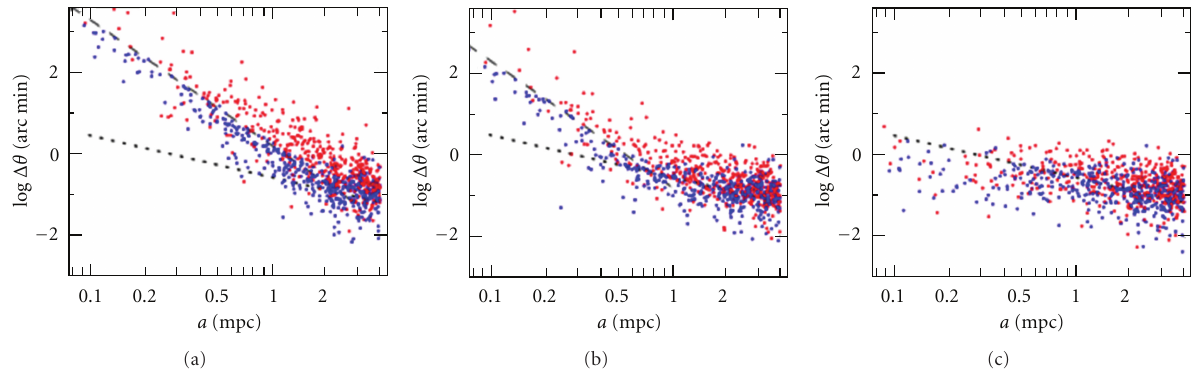
Figure 6: Evolution of the orbital angular momenta of stars around Sgr A ∗ due to frame-dragging (dashed lines) and stellar perturbations (dotted lines) as measured by the angle Δ θ as a function of the orbital semimajor axis a . The three panels correspond to a Kerr black hole with a spin (a) a = M, (b) a = 0 . 1 M, and (c) a = 0 [30].